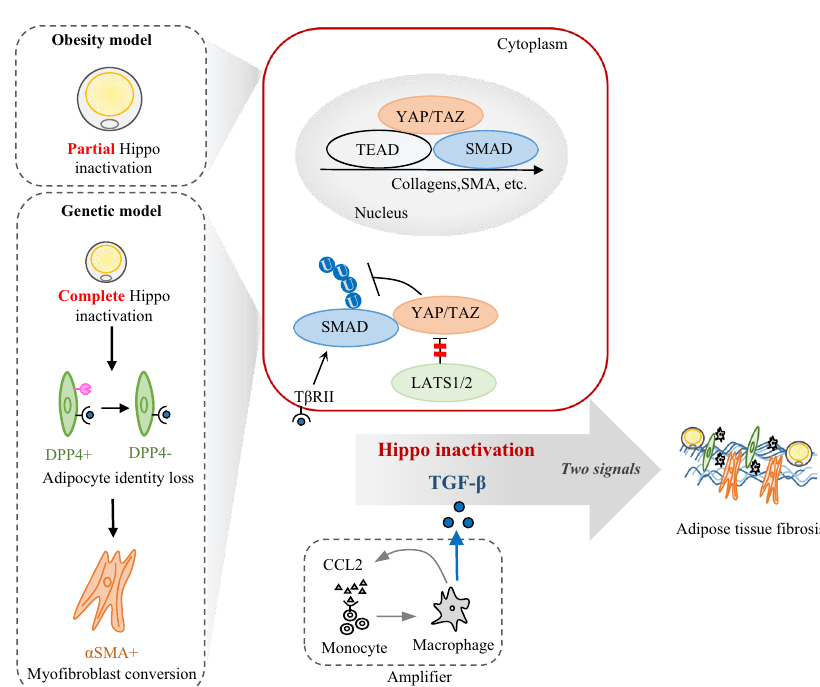
Fig. 7 | Targeting YAP/TAZ to relieve AT fi brosis in obese mice. a – e Yap f/f Taz f/ f Adipoq CreERT2 (YT-iAKO) or YT-FF mice were fed a HFD for 11 weeks followed by i.p. injection of 5 doses of tamoxifen (50mg/kg) every day ( n =6). a Experimental scheme. b mRNA expression of fi brosis markers in scWAT from YT-FF or YT-iAKO mice( n =6). c RepresentativescWATsectionswithPicrosiriusredstainingofYT-FF orYT-iAKOmice. d , e Glucosetolerancetest(GTT)( d )orinsulintolerancetest(ITT) ( e ) ofYT-FF ( n =6) or YT-iAKO ( n =7) mice. f – l Eight-week-old ob/ob mice were i.p. injected with Veh or vertepor fi n (VP) (25mg/kg) for 5 doses every other day.